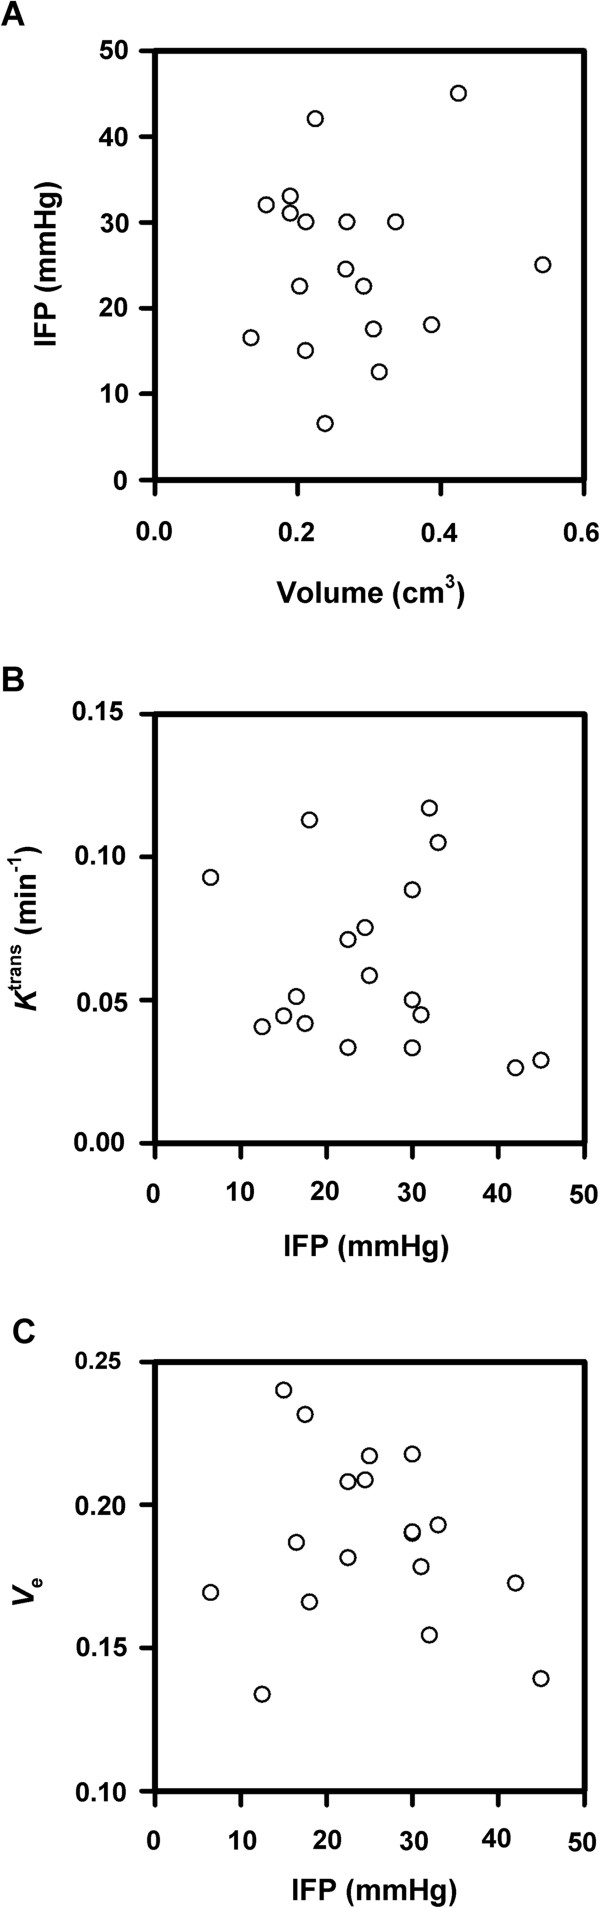
DCE-MRI and IFP data for CK-160 cervical carcinoma xenografts imaged with Gd-DTPA as contrast agent. (A) IFP versus tumor volume. (B) Median Ktransversus IFP. (C) Median veversus IFP. The points represent single tumors.